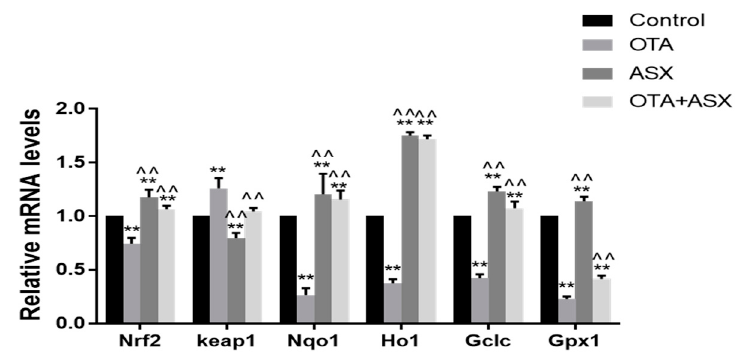
Figure 6. Gene expression in the NRF2/KEAP1 signaling pathway.